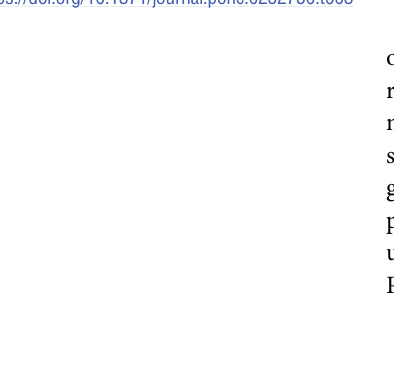
overall score of 25 (there was no statistical difference between the groups, p = 0.551). The null results in the comparison between groups led us to conduct a post hoc power analysis to deter- mine if our study was adequately powered. The priori analysis indicated that a power (1 - β ) set at 0.80 and α = .05, two-tailed, sample sizes are suggested to include 67 participants in each group to detect medium effects (d = .5); large effects (d = .8) could be detected with only 27 participants in each group. However, the post hoc analysis to determine achieved power based upon means and standard deviations for each group yielded an effect size d = 0.117 with Power = 0.099.